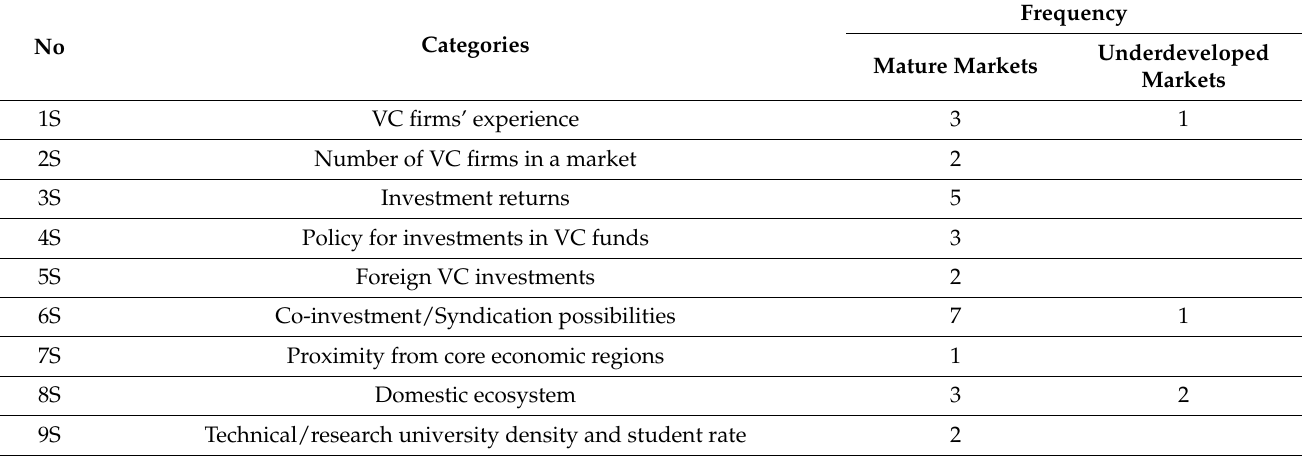
Table 4. The factors influencing VC